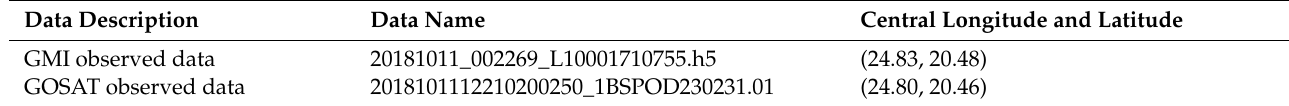
Table 8. Cross-validation data information.